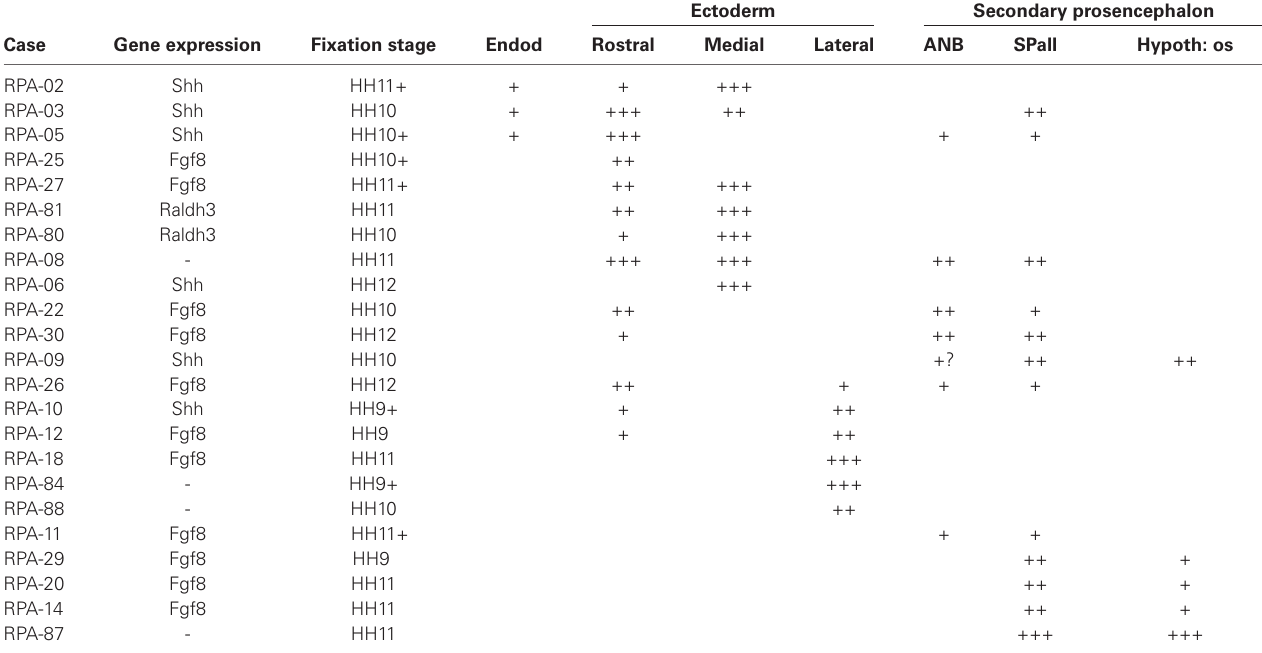
The relative amount of labeled cells filling the respective AP (medial-lateral) or DV (dorsoventral) territories is estimated roughly as “few cells” (+), “up to half the domain is labeled” (++) and “most or all the domain is labeled”